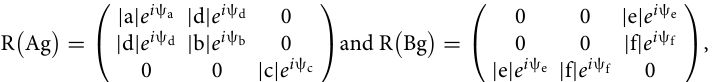
where e i and e s are the unit vectors of the polarization of the incident and the scattered lights, respectively, and R represents the Raman tensor for the Raman-active phonon mode. For the incident light with its polarization direction making angle θ with respect to the crystal y-axis, e i = (0 cosθ sinθ) and e s = (0 cosθ sinθ) or e s = (0 − sinθ cosθ) for parallel or perpendicular polarization configurations, respectively. Similar to BP 9 , the Raman tensor elements of GaTe are complex numbers, and the Raman tensors for the A g and the B g modes of GaTe can be expressed as